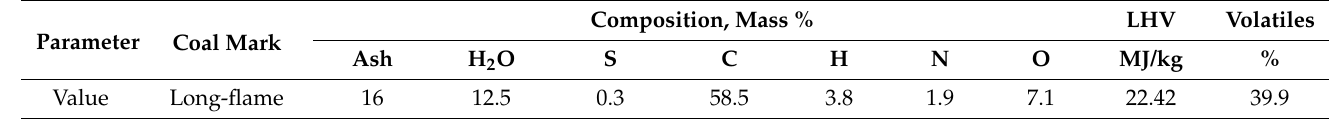
Table 7. Taldinsky coal